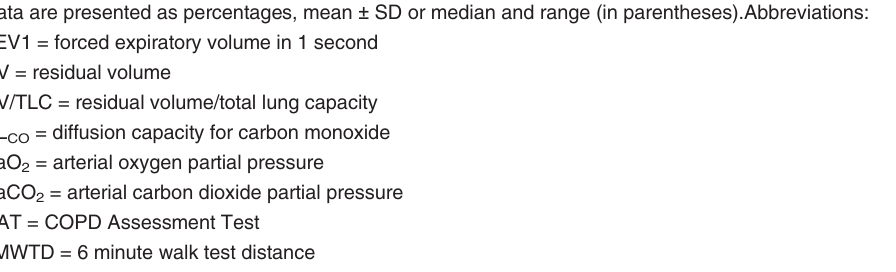
Data are presented as percentages, mean ± SD or median and range (in parentheses).Abbreviations: FEV1 = forced expiratory volume in 1